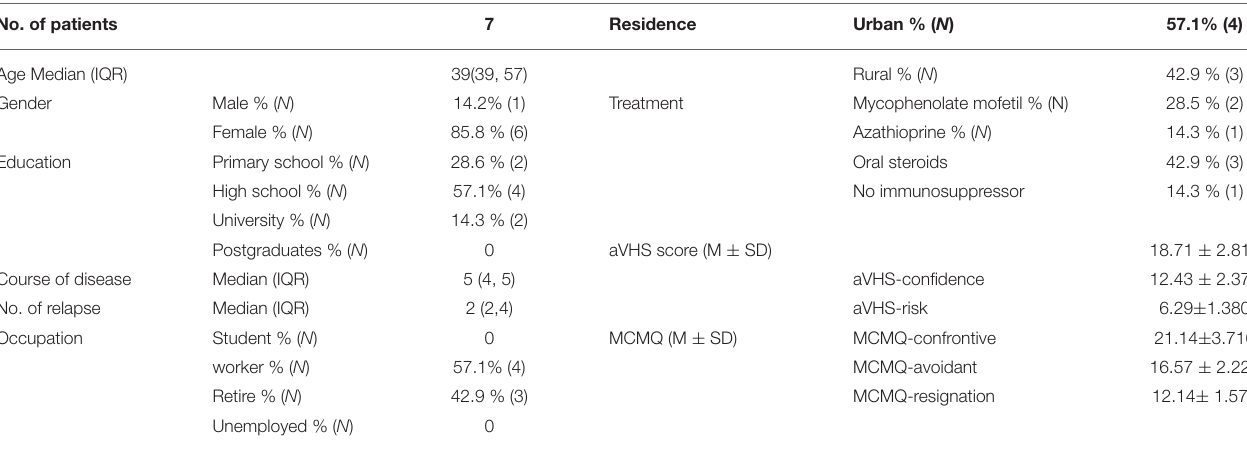
TABLE 4 | Characteristics of NMOSD patients who received COVID-19